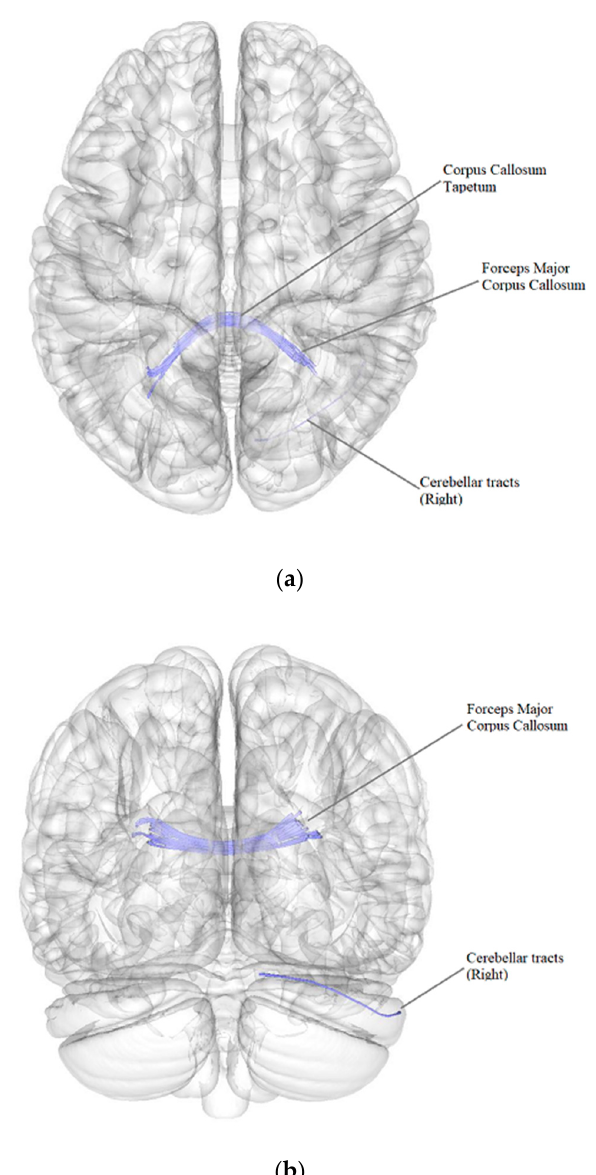
Figure 2. Three-dimensional reconstruction of the white matter tracts with the signs of a decrease in quantitative anisotropy in patients after BC treatment with the presence of PMPS in comparison with patients after BC treatment without PMPS (( a ) axial plane, ( b ) coronal plane). Table 5. White matter tracts with lower quantitative anisotropy in patients after BC treatment with the presence of PMPS in comparison with patients after BC treatment without PMPS.